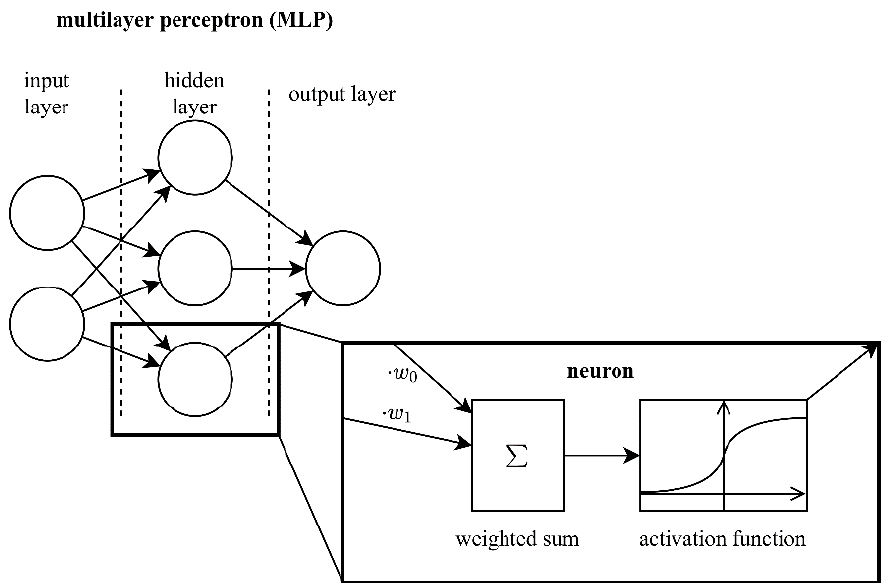
Figure 1. A multilayer perceptron (MLP) consists of neurons organized in layers. Each neuron is composed of a weighted sum of all inputs and an activation function to define the output.